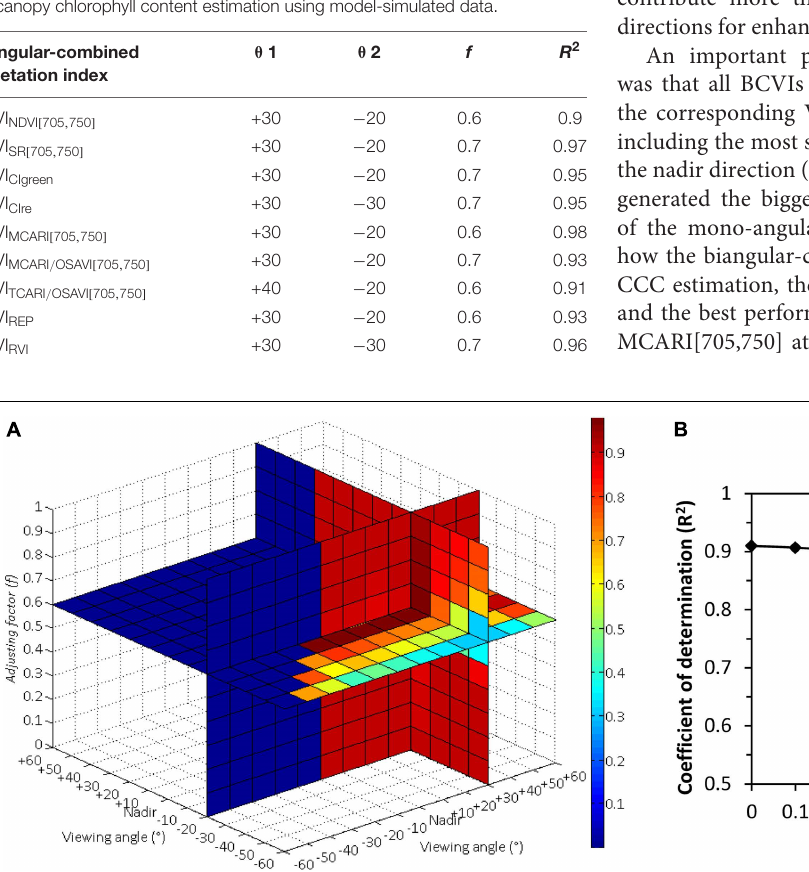
FIGURE 5 | (A) The optimum three-dimensional slice map of the coefficients of determination ( R 2 ) for relationship between the canopy chlorophyll content and biangular-combined vegetation indices (BCVI) MCARI [ 705 , 750 ] calculated by the modified chlorophyll absorption ratio index (MCARI)[705,750] at all the possible two-angle observations selected from 13 viewing angles between –60 ◦ and +60 ◦ , in which an adjusting factor f varied from 0 to 1 at a step of 0.1. (B) Changing curve of R 2 for relationship between canopy chlorophyll content and BCVI MCARI [ 705 , 750 ] at +30 ◦ and –20 ◦ angle combination along with variety of f values.